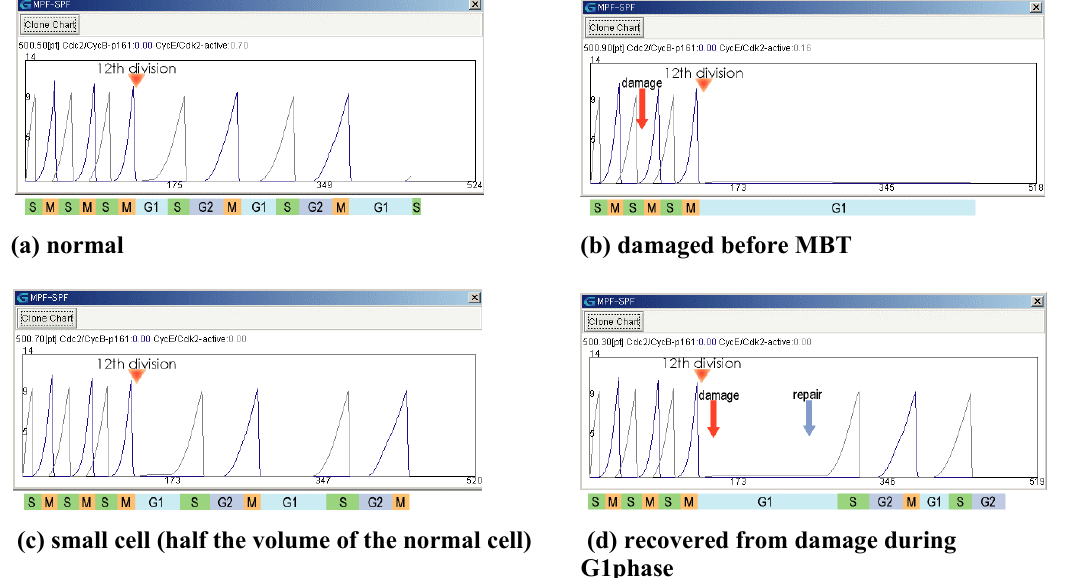
Figure 4 . Simulation results of MPF and SPF concentration behaviors. (a) Normal cell. Both oscillation cycles of MPF and SPF concentrations change after the 12th division (G1 and G2 phases are inserted). (b) DNA is damaged before the 12th division. Oscillations stop at the 12th division due to checkpoint mechanisms. (c) Small cell. The volume of the small cell is half of the normal cell. The period of oscillation is longer than the normal cell. (d) A cell is damaged soon after the 12th division, but recovers from the damage during G1